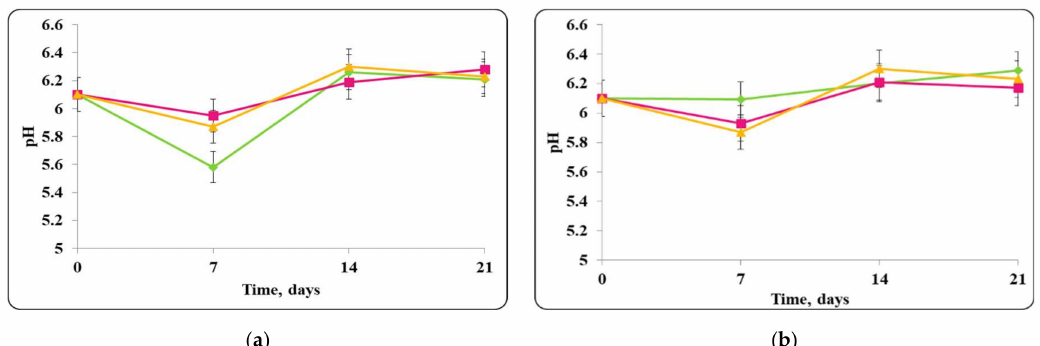
Figure 14. ( a ) free lactobacilli cells; ( b ) encapsulated lactobacilli cells. Changes in the pH of the chocolate mousse inoculated with Lb. helveticus 2/20 and S. aureus ATTC 25923 during storage at 4 ± 2 ◦ C. Legend: Green (cid:117) : pH of chocolate mousse inoculated with Lb. helveticus 2/20; Pink (cid:4) : pH of chocolate mousse co-inoculated with Lb. helveticus 2/20 and S. aureus ATCC 25923; Yellow (cid:78) : pH of chocolate mousse inoculated with S. aureus ATCC